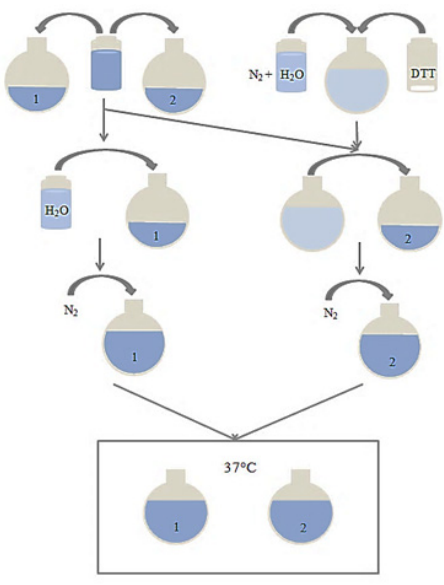
Figure 1. Schematic of method used for testing nanoparticle degradation.